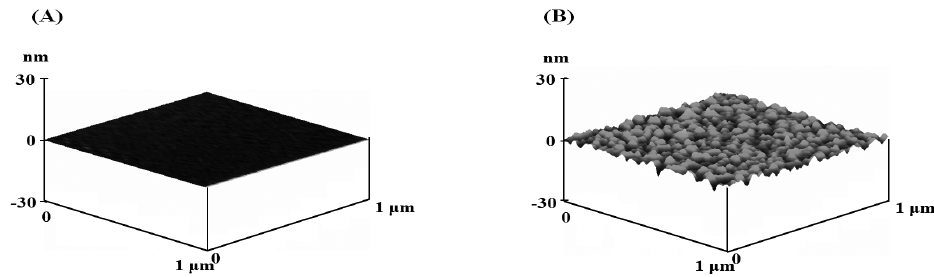
Figure 1. Surface morphology ( A ) before the lipid vesicle adsorption ( B ) after the adsorption.